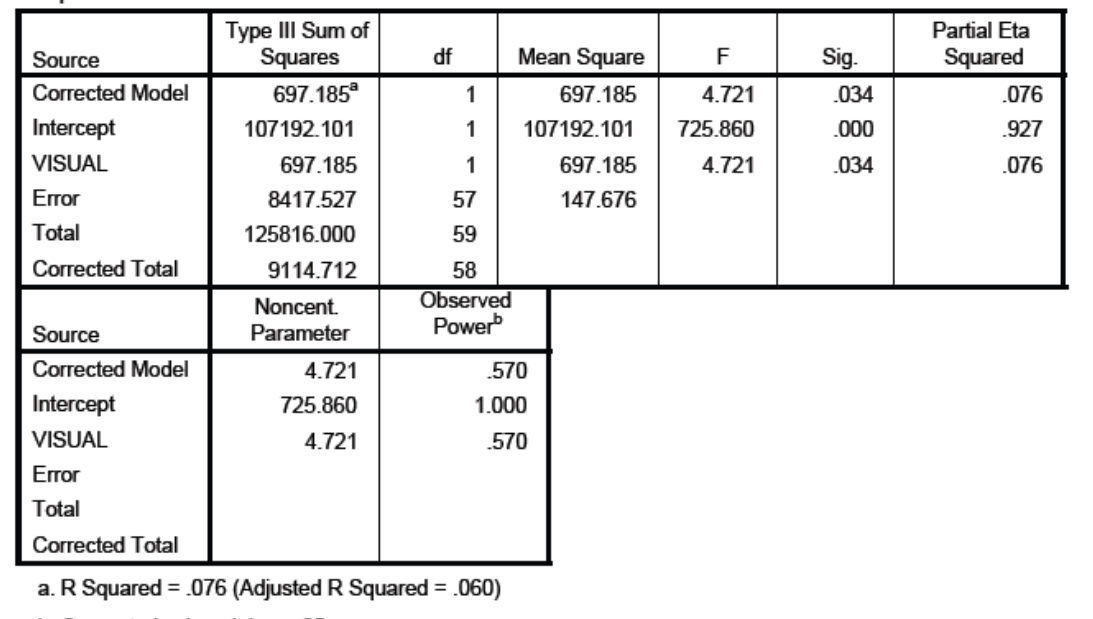
Figure B.10. ANOVA analysing engagement levels in regard to visual preference using raw